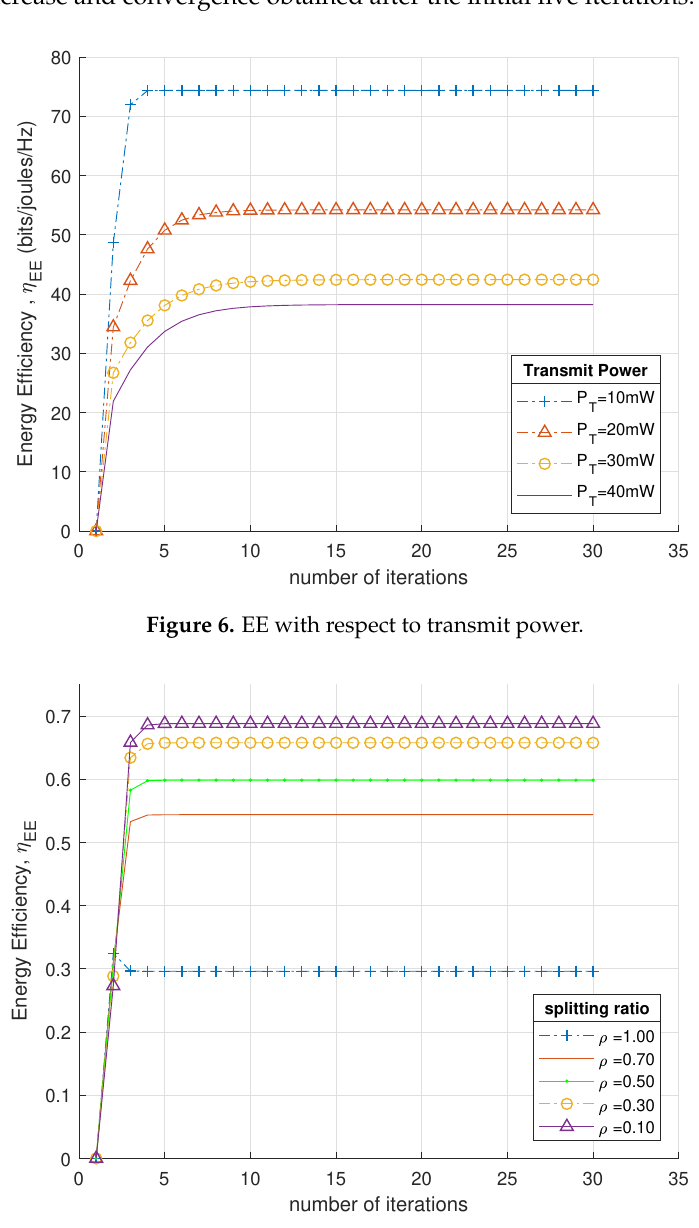
Figure 7. EE with respect to splitting